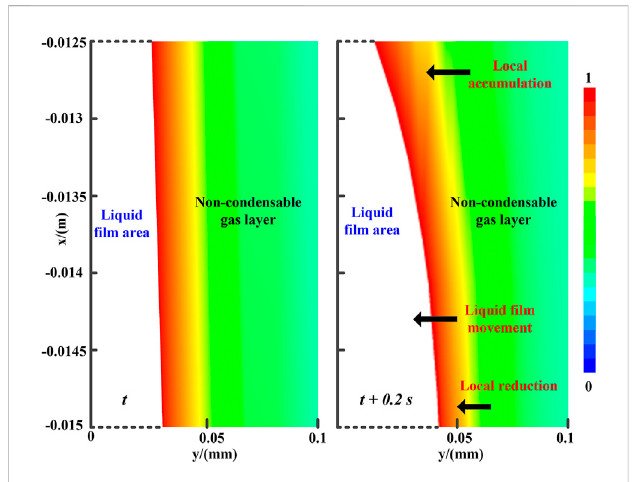
FIGURE 12 Local change of air concentration in the process of the liquid fi lm falling off of Case 5.